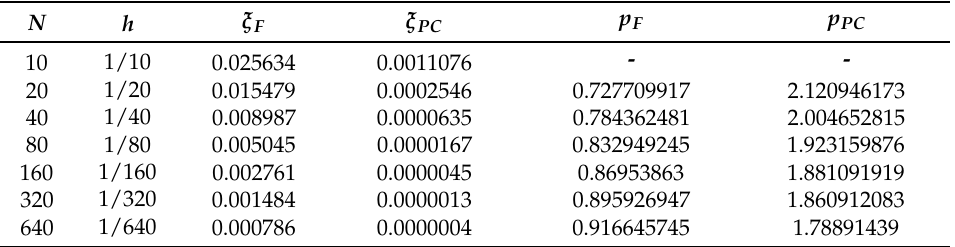
Table 2. Error analysis of numerical methods ENFDS and ABM for β = 1.8, γ = 0.9 according to Runge’s rule (26).